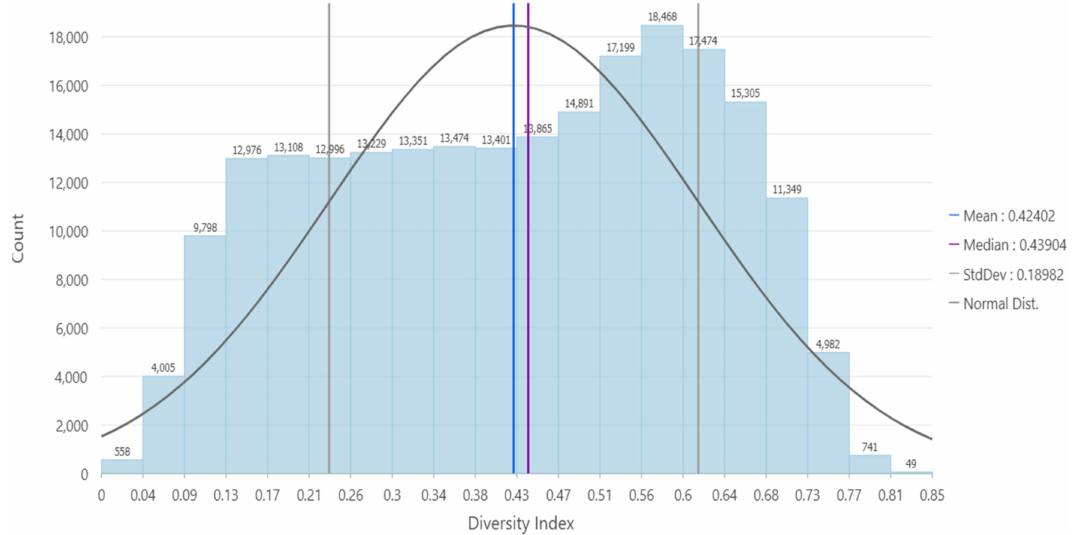
Figure 10. Histogram of Block Group Diversity Indices,